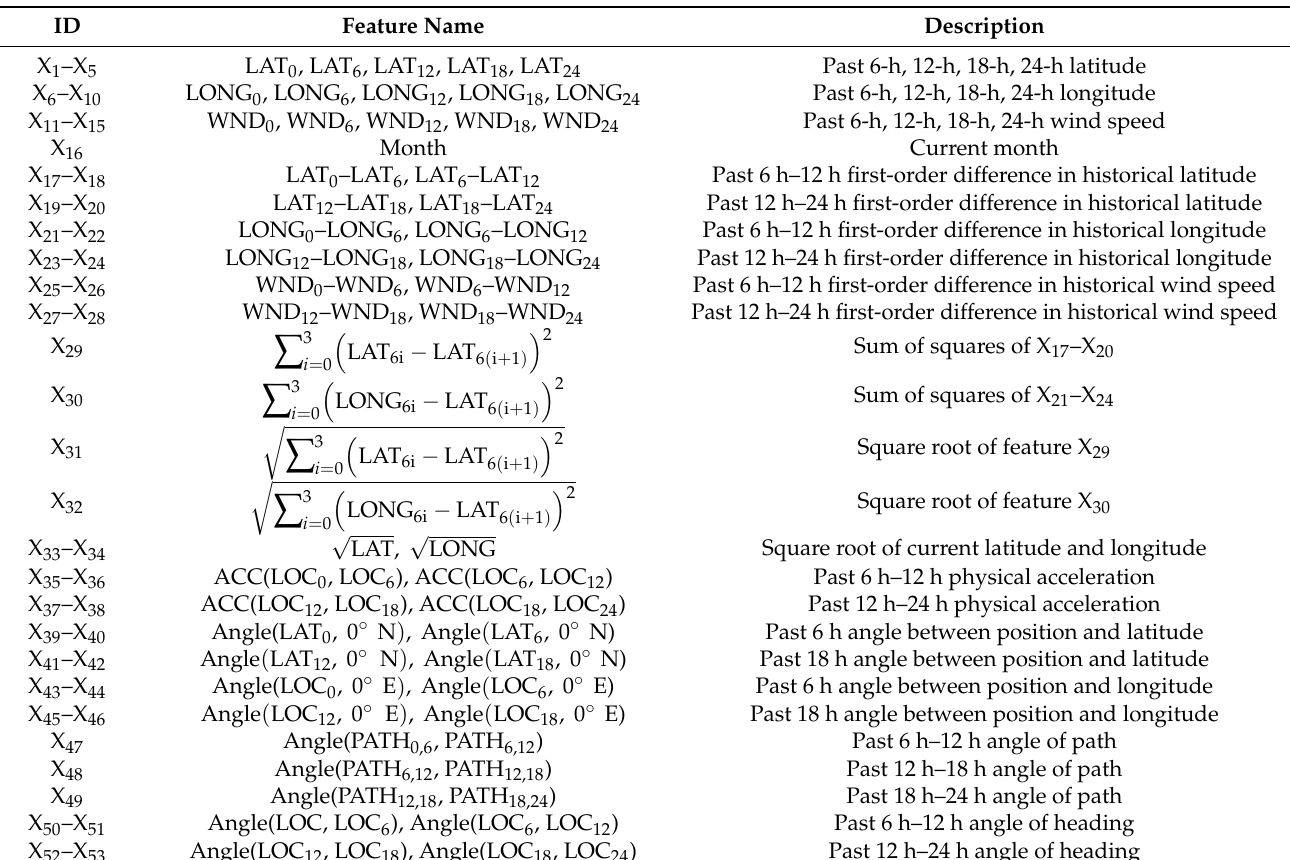
Table 1. Two-Dimensional Characteristics of Tropical Cyclone